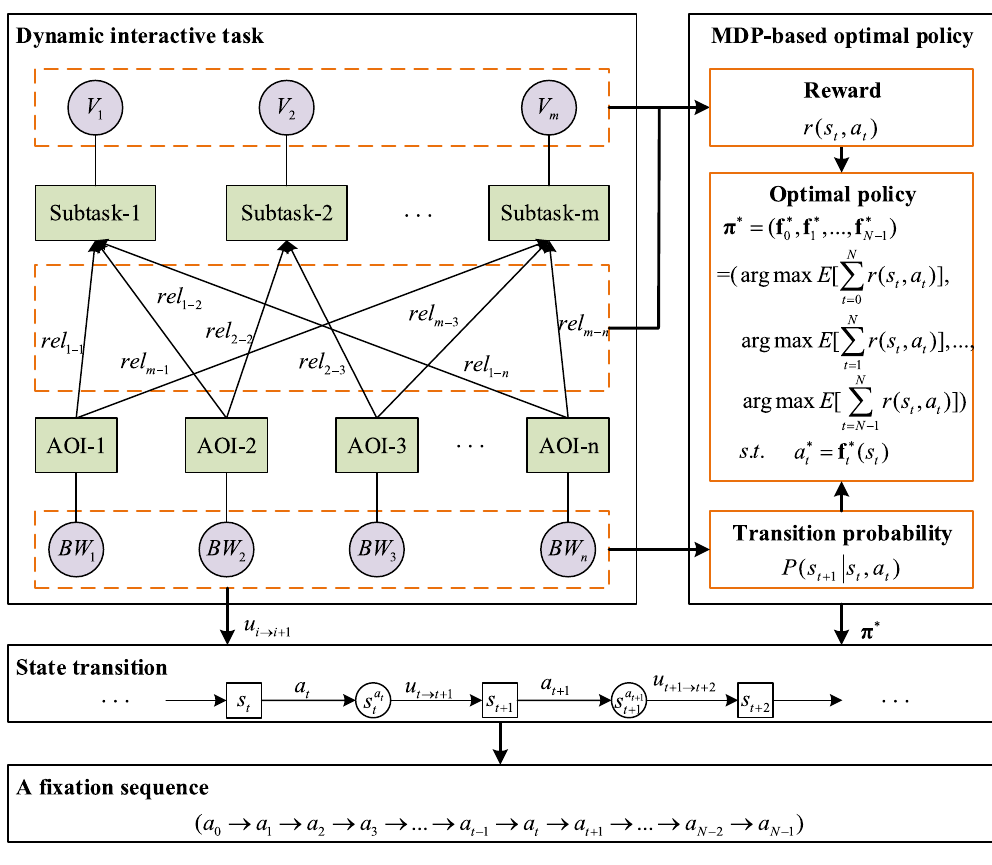
Figure 1. The framework of the eye movement